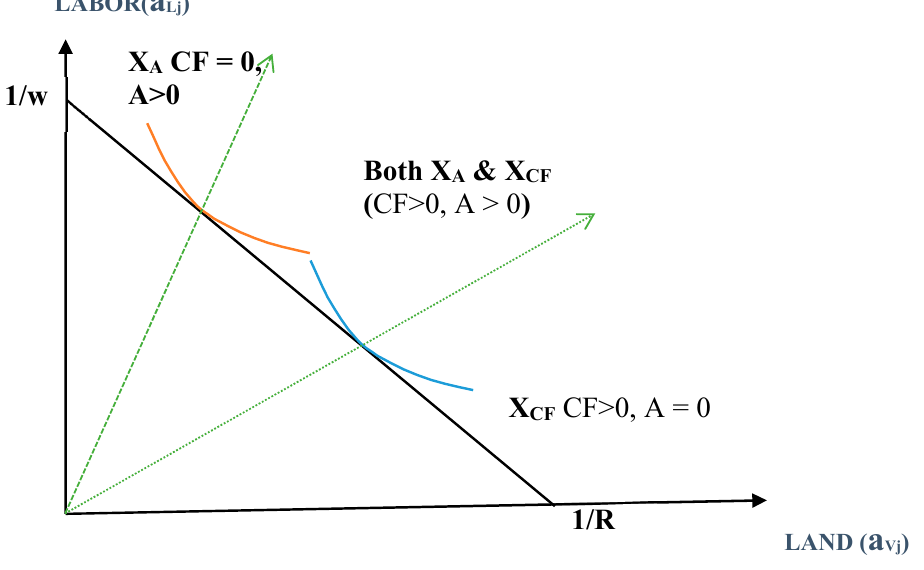
Figure 4. Food-sector and contract farming outputs under different specialization patterns. Source: Authors’